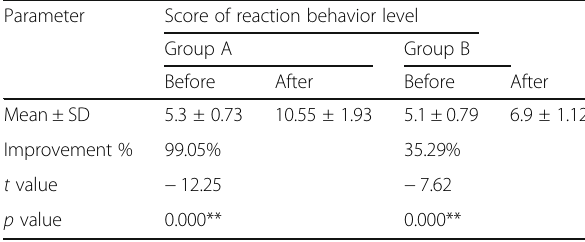
Table 3 Comparison of mean scores of reaction behavior level pre and post treatment within each